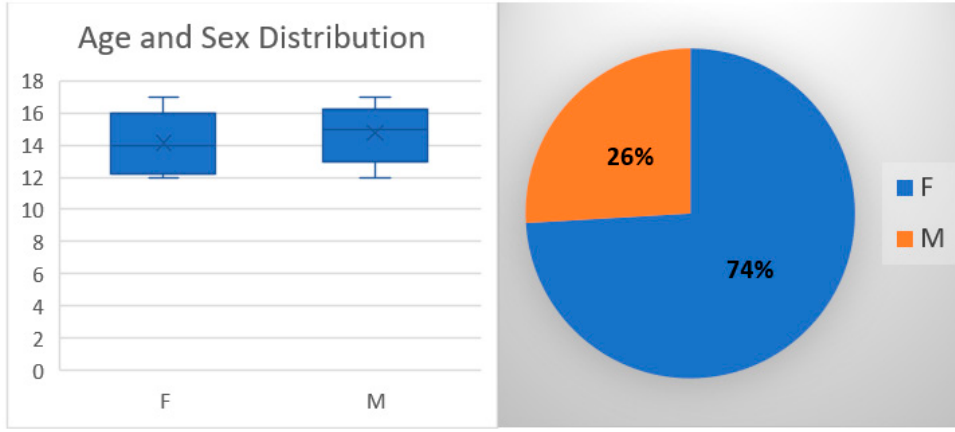
Figure 1. Age and sex